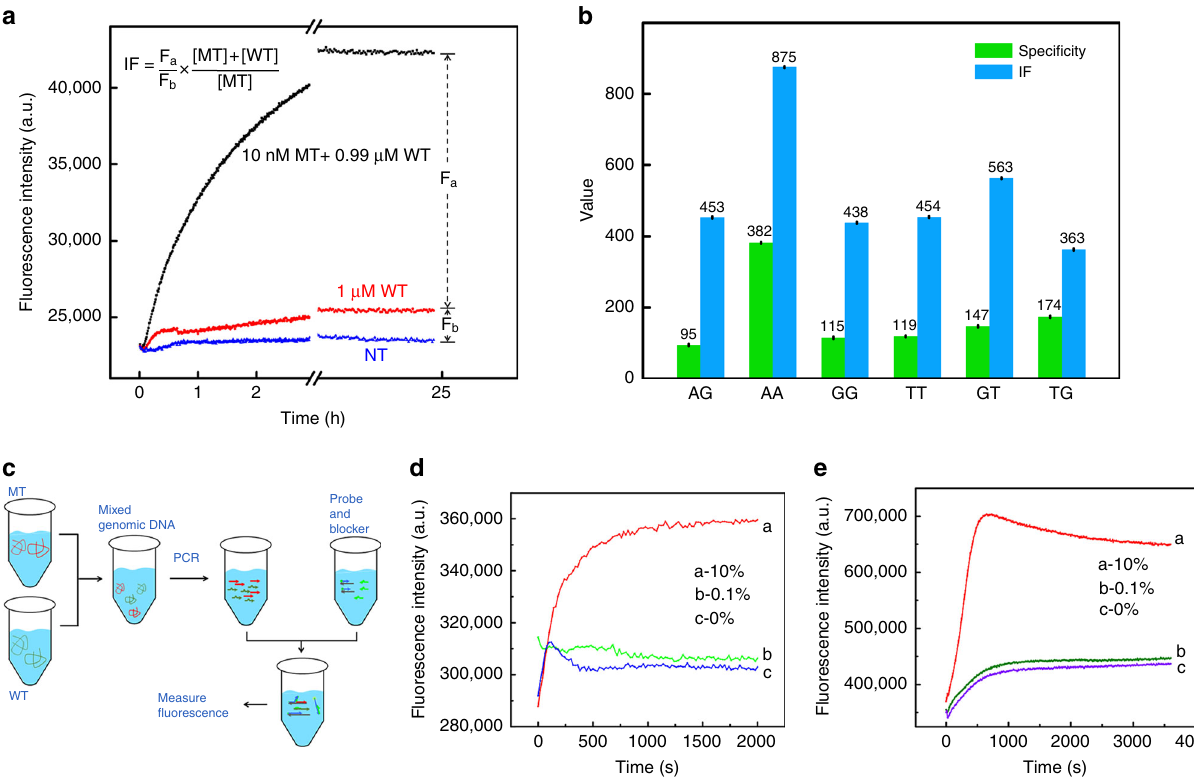
Fig. 4 Functionality and clinical practicability of the 4-way SELECT system. a De fi nition of the relative increase of fl uorescence intensity at low variation frequencies (abbreviated as IF). b The speci fi city and IF values of dissociative 4-way SELECT system towards six different types of mismatches. c The work fl ow of post-PCR detection of low-abundance point mutation. d , e Detection of low-abundance point mutations using the dissociative 4-way SELECT system ( d ) and the non-dissociative 4-way SELECT system ( e ). Source data are provided as a Source Date fi